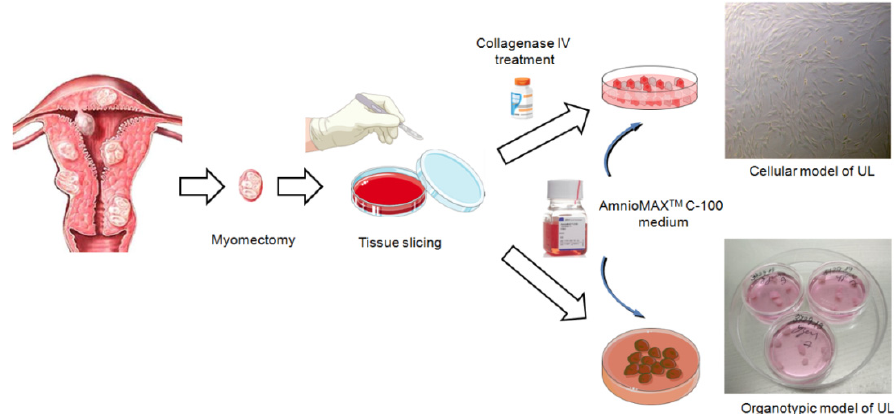
Figure 1. Representative scheme of UL cellular and organotypic model development.